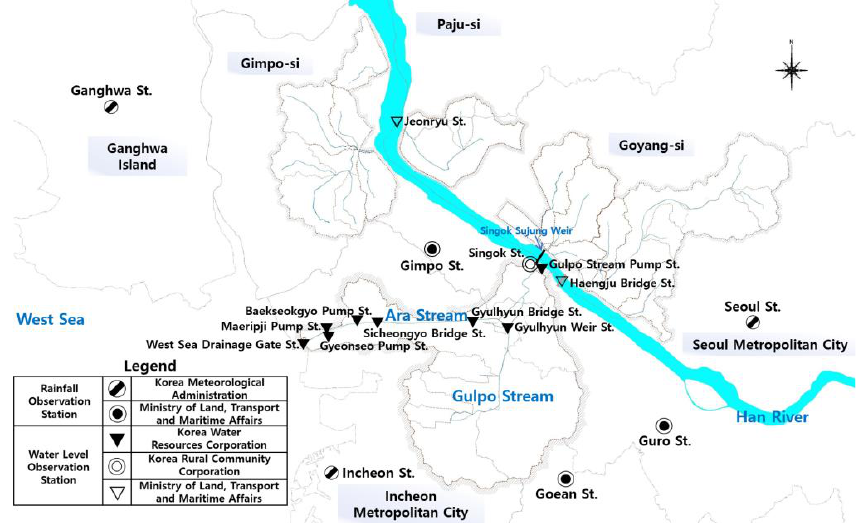
Figure 3. Hydrological Observatory